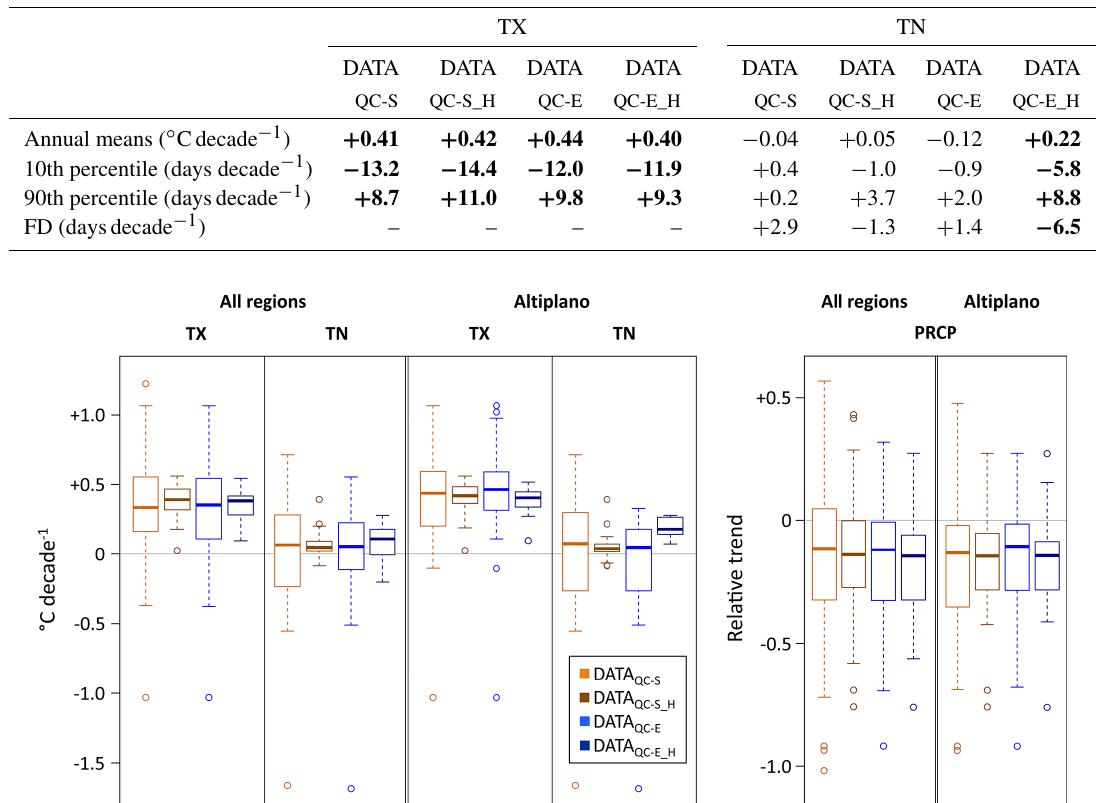
Table 5. Trends of spatially averaged anomalies in the Altiplano ( ≥ 3500ma . s . l . ) in the period 1981 to 2010. Trends are shown for the annual means, for the 10th and 90th percentile of maximum temperature (TX) and minimum temperature (TN; i.e. TX10p, TN10p, TX90p, TN90p), and for the number of frost days (FD). Bold numbers denote significance at the 5% level.